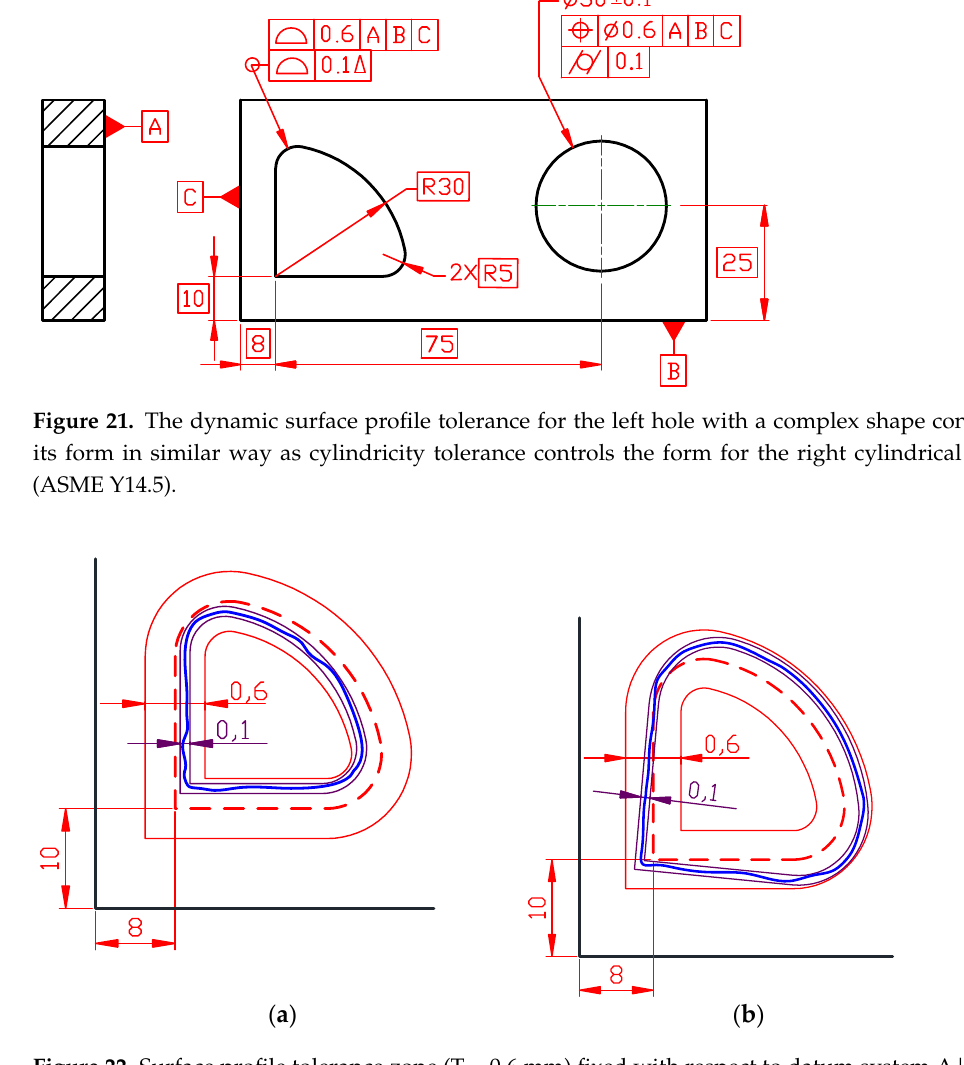
Figure 21. The dynamic surface profile tolerance for the left hole with a complex shape controls its form in similar way as cylindricity tolerance controls the form for the right cylindrical hole (ASME Y14.5).